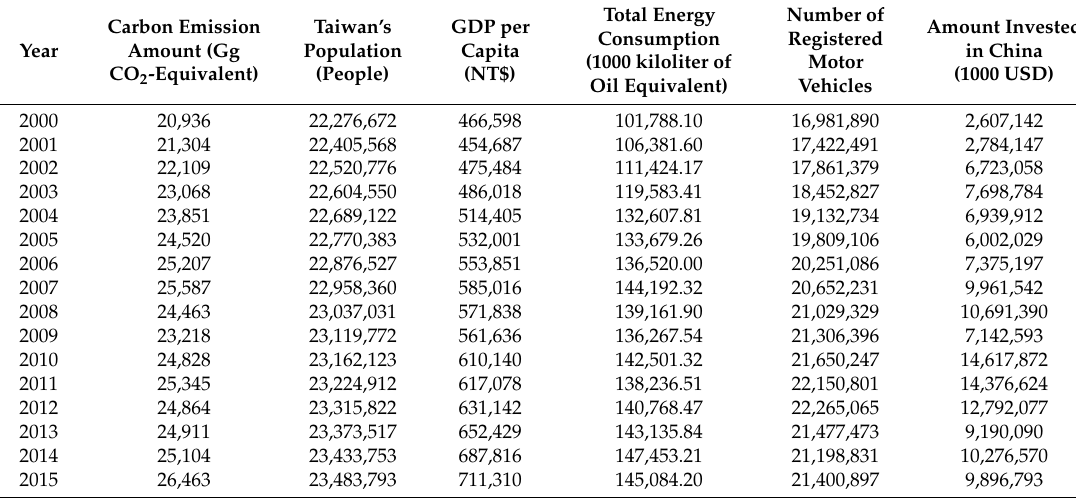
Table 2. Various raw data.